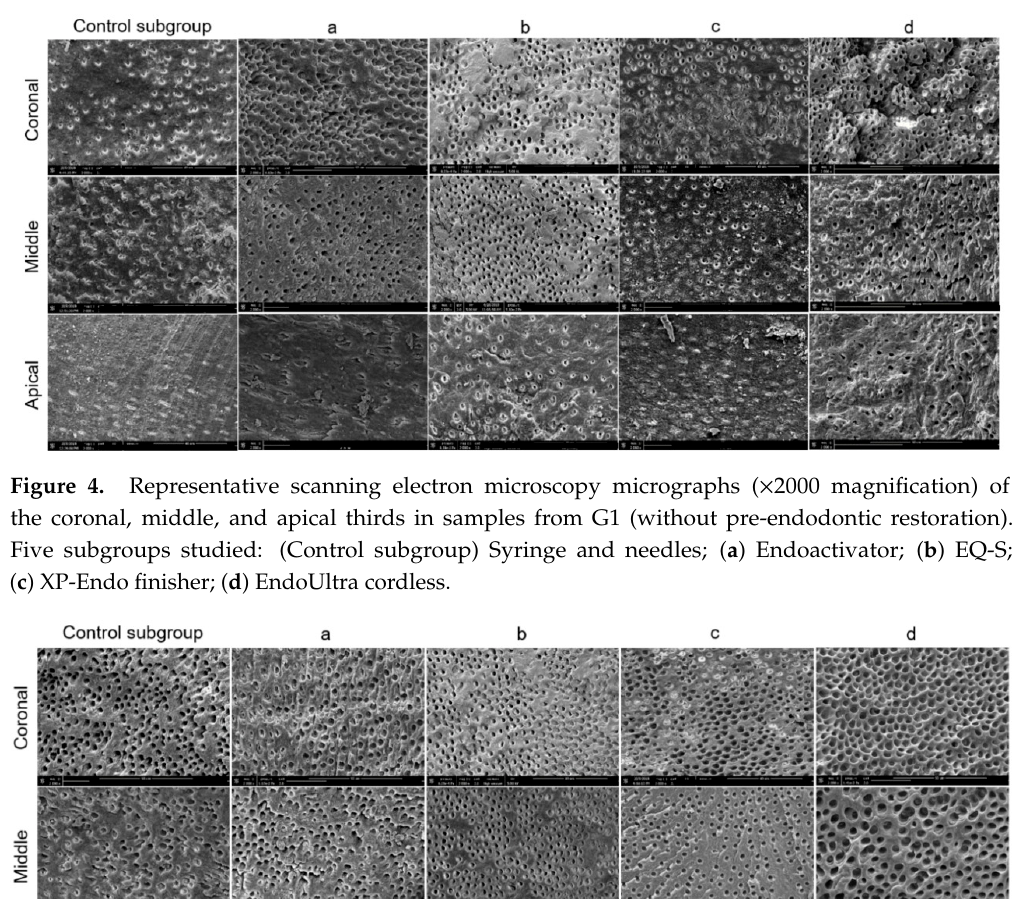
Figure 3. Representative scanning electron microscopy micrographs of longitudinal sectioned root surfaces after the shaping procedure. ( a ) Coronal third (×30 magnification); ( b ) middle third (×30 magnification); ( c ) apical third (×30 magnification); ( d ) coronal third (×2000 magnification); ( e ) middle third(×2000 magnification); ( f ) apical third (×2000 magnification).